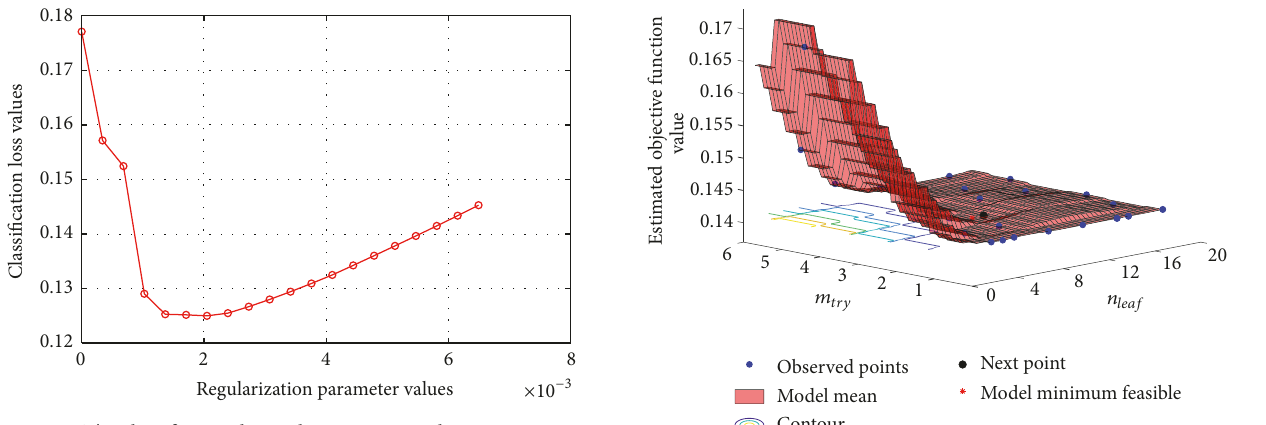
Figure 2: The classification loss values versus regularization param- eter values.